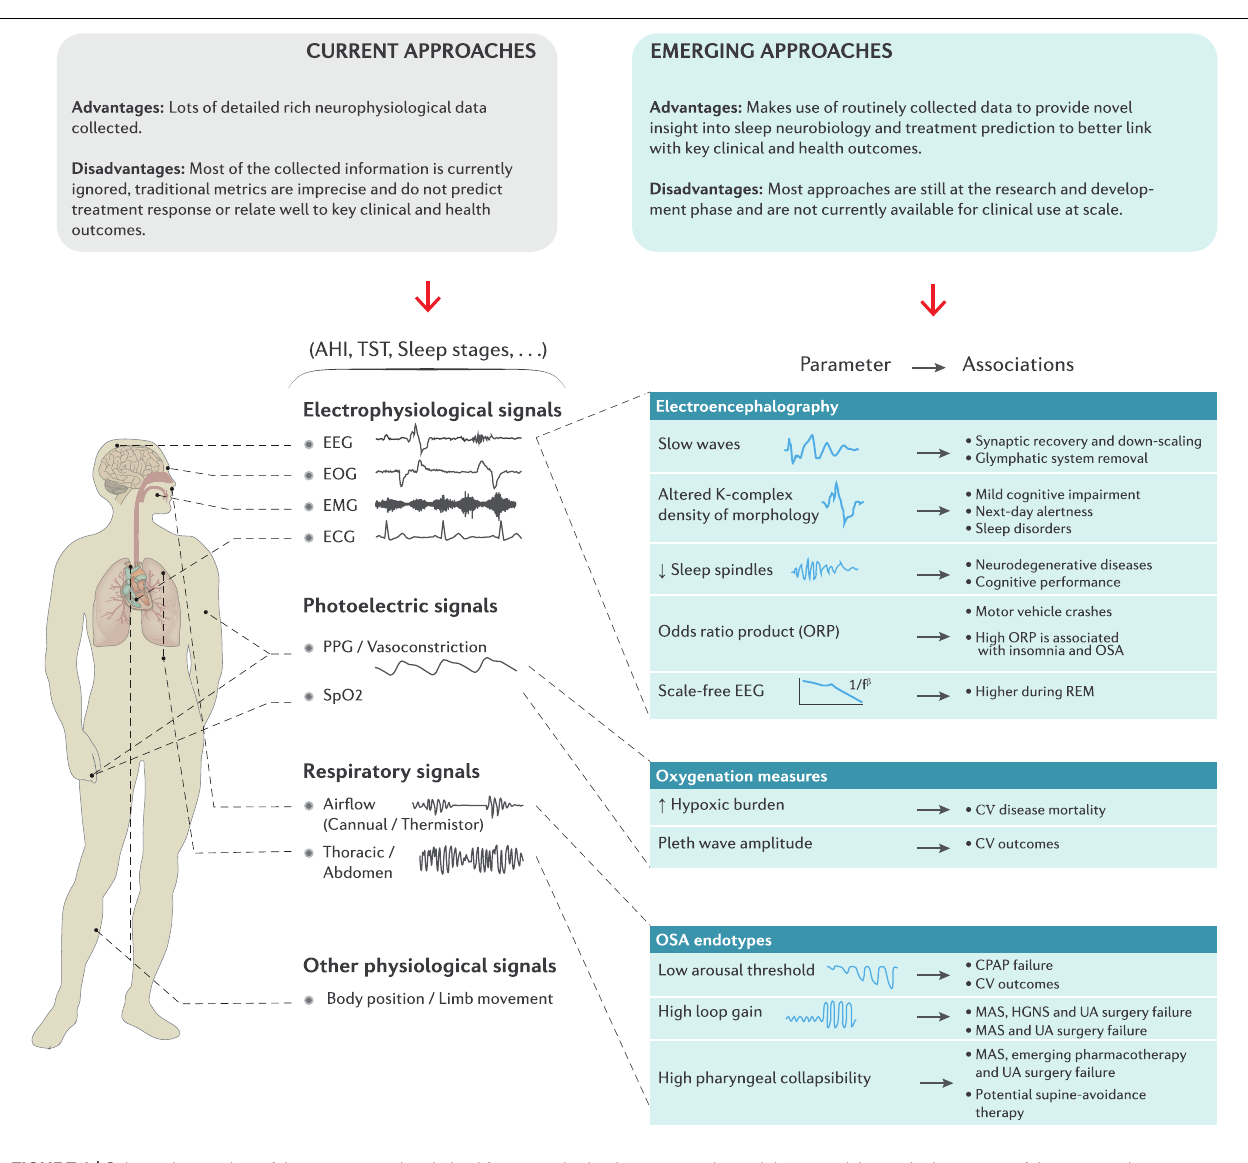
Frontiers in Neuroscience |